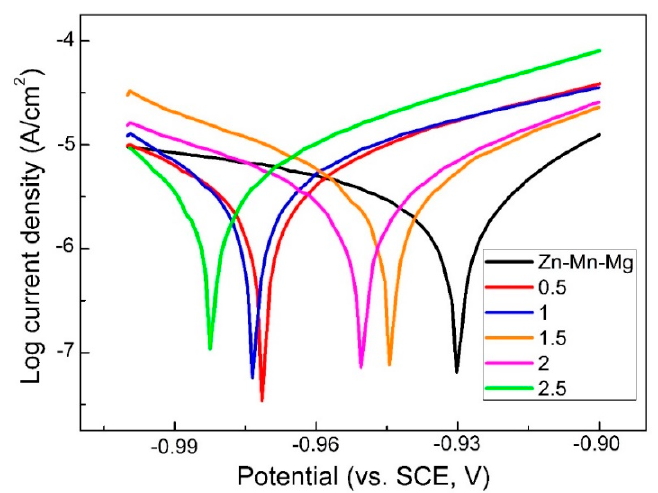
Figure 5. The polarization curves of MAO coating with different NaF concentrations from 0.5 g/L to 2.5 g/L in Hank’s solution at 37 °C.